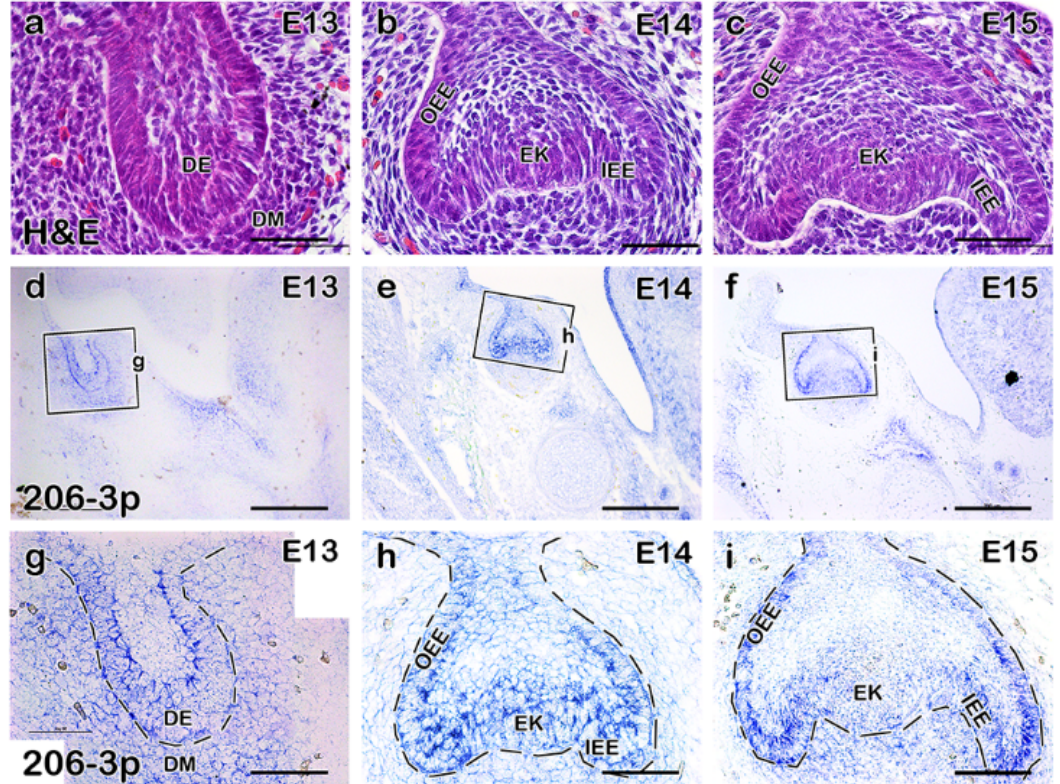
Figure 1. Expression of miR-206-3p in the developing tooth. Expression of miR-206-3p in the developing tooth. Developing teeth are at the bud and cap stages at E13-E15 ( a – c ). Section in situ hybridization using miRCURY LNA TM miRNA Custom Detection Probe for miR-206-3p was performed to detect the expression of miR-206-3p in the developing tooth at the bud and cap stages ( d – i ). Specific expression of miR-206-3p was detected in the dental epithelium and condensed mesenchyme at E13 ( d , g ). The expression was more restricted to the epithelium, including IEE, OEE, and EK at E14 ( e , h ). At E15, the expression was detected in IEE and OEE ( f , i ). Schematic diagram showing the expression of miR-206-3p ( g – i ). DE; dental epithelium, DM; dental mesenchyme, EK; enamel knot, IEE; inner enamel epithelium, OEE; outer enamel epithelium. Rectangular boxes indicate the magnified regions of the developing tooth ( d – f ), and the dotted lines indicate the boundary of the epithelium ( g – i ). Scale bars 200 µm ( d – f ), 50 µm ( a – c , g – i ).